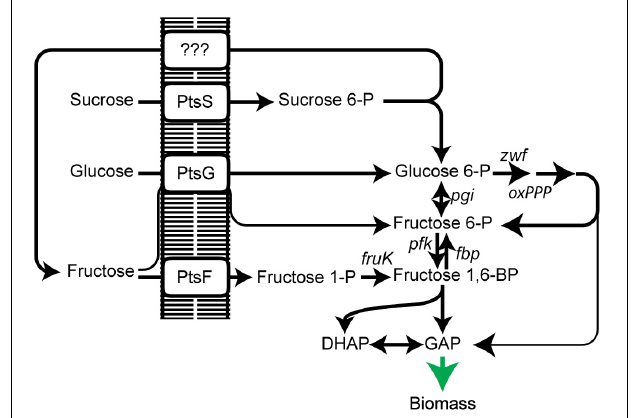
FIGURE 1 | Scheme of PTS-dependent uptake and utilization of sugars sucrose, glucose, and fructose in C. glutamicum . PtsS, sucrose PTS; PtsG, glucose PTS; PtsF, fructose PTS; oxPPP, oxidative pentose phosphate pathway; pgi, phosphoglucose isomerase; pfk, 6-phosphofructokinase; fbp, fructose 1,6-bisphosphatase; fruK, 1-phosphofruktokinase; DHAP, dihydroxyacetone phosphate; GAP, glyceraldehyde 3-phosphate. Data represent one of two individual cultivations, which differed <